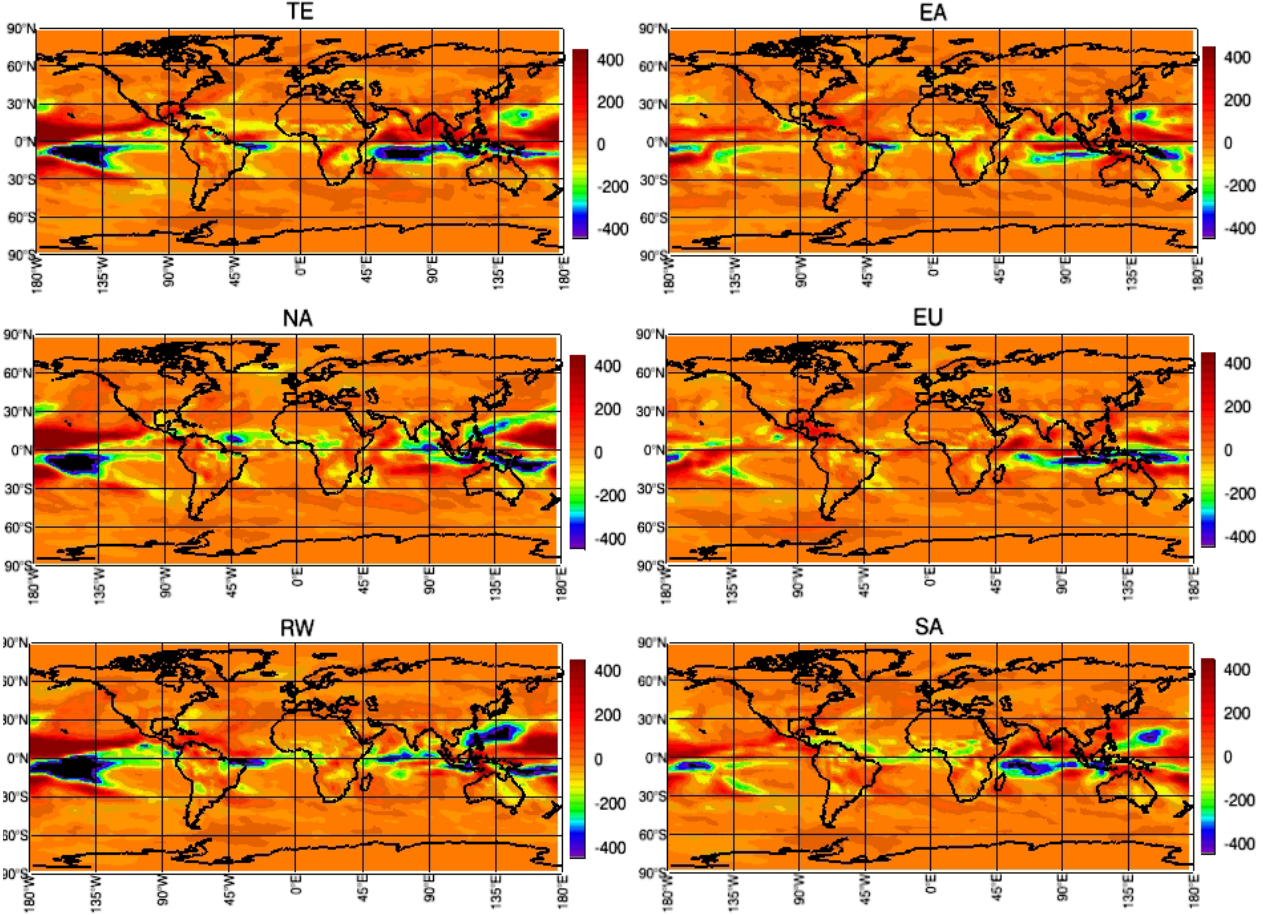
Fig. 2. Changes in annual mean convective precipitation caused by BC aerosols. Results are derived from model runs driven by BC emissions from: (a) all around the globe (TE), East Asia only (EA), North America only (NA), Europe only (EU), South Asia only (SA), and rest of the world (RW). Data are year 41–60